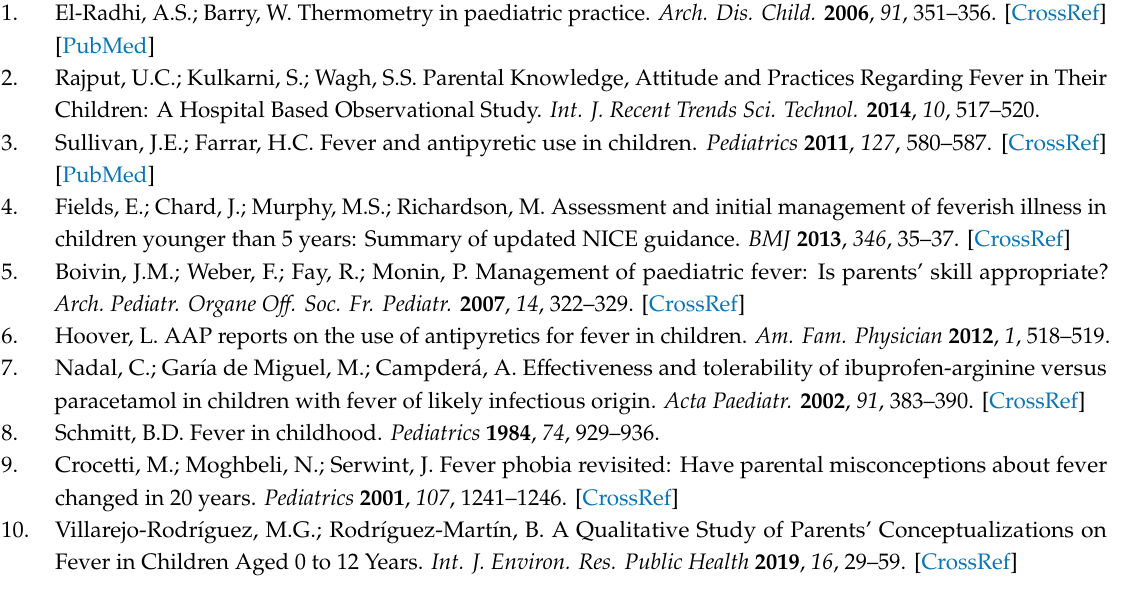
Table S1: Themes, categories and codes, Table S2: Consolidated criteria for reporting qualitative research (COREQ). Author Contributions: Conceptualization, M.G.V.-R. and B.R.M.; methodology, M.G.V.-R. and B.R.M.; data collection, M.G.V.-R.; writing—original draft preparation, M.G.V.-R. and B.R.M.; writing—review